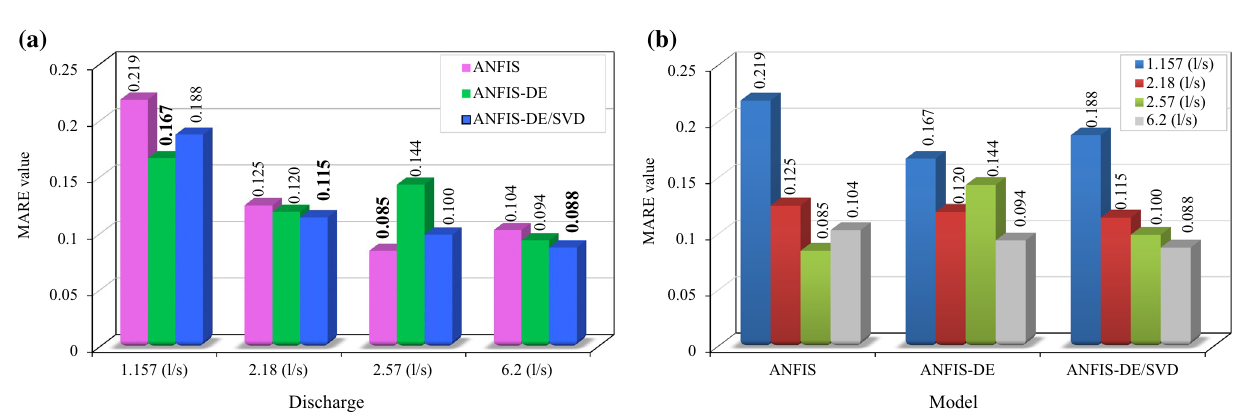
Fig. 9 Bar graphs error index MARE a at each discharge for three ANFIS, ANFIS-DE and ANFIS-DE/SVD models and b evaluation of the model performance at each model at four different